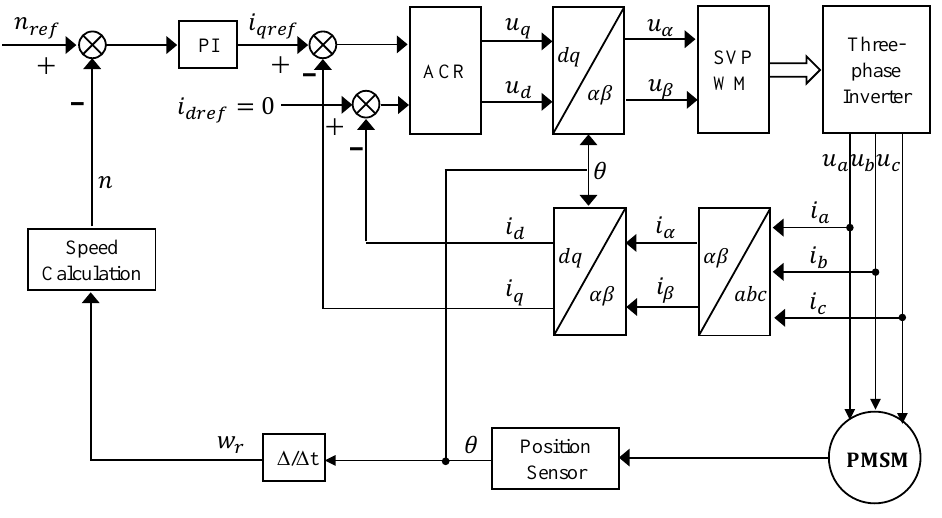
Figure 1. Structure of the PMSM vector control system. The deviation signals obtained by comparing i dref , i qref with i d , i q are passed through the automatic current regulator (ACR) to obtain the voltage signals u d , u q in the d-q